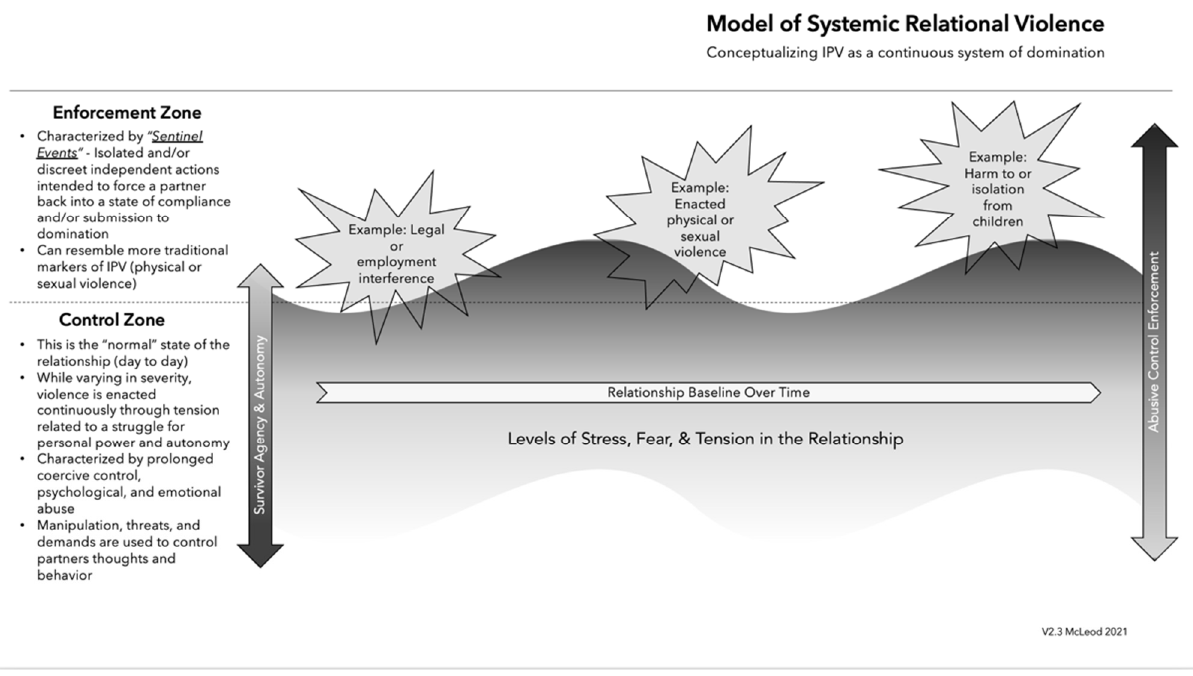
Figure 1. Model of Systemic Relational Violence.